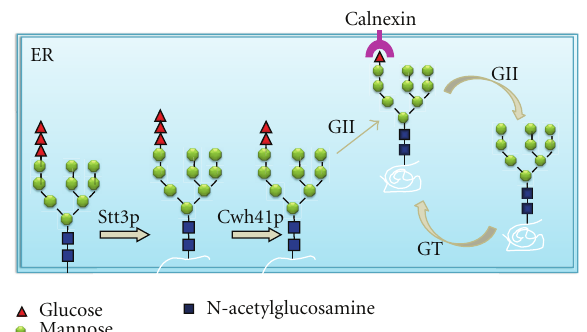
Figure 2: N-glycan-dependent quality control of protein folding in A. fumigatus . In A. fumigatus , the N-glycan-dependent QC system is composed of calnexin, UDP-glucose: glycoprotein glucosyltrans- ferase (GT) and glucosidase II